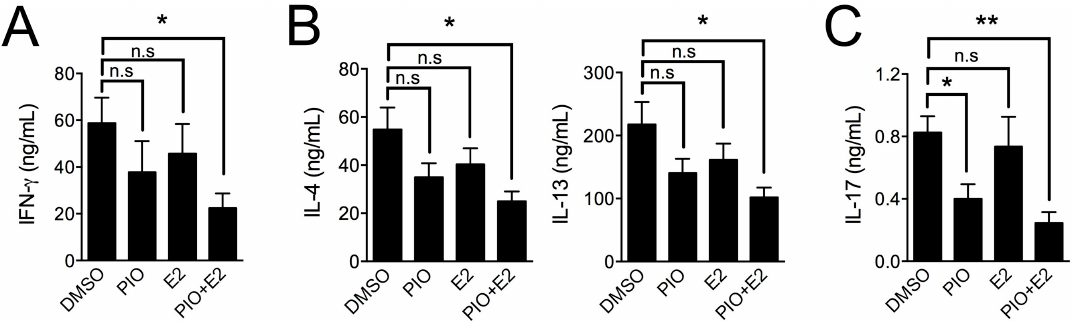
Figure 6. Co-treatment with pioglitazone and estradiol suppresses lineage-specific cytokine production in male Th1, Th2, and Th17 cells. Cultured supernatants from male cells treated with DMSO, pioglitazone (20 μ M), estradiol (5 nM), or pioglitazone (20 μ M) + estradiol (5 nM) were analyzed by ELISA assay to determine the production of IFN- γ in Th1 cells ( A ); IL-4 and IL-13 in Th2 cells ( B ) and IL-17A in Th17 cells ( C ). Values represent mean ± SEM ( n = 4~5). * p < 0.05, ** p < 0.01; n.s: non-significant.